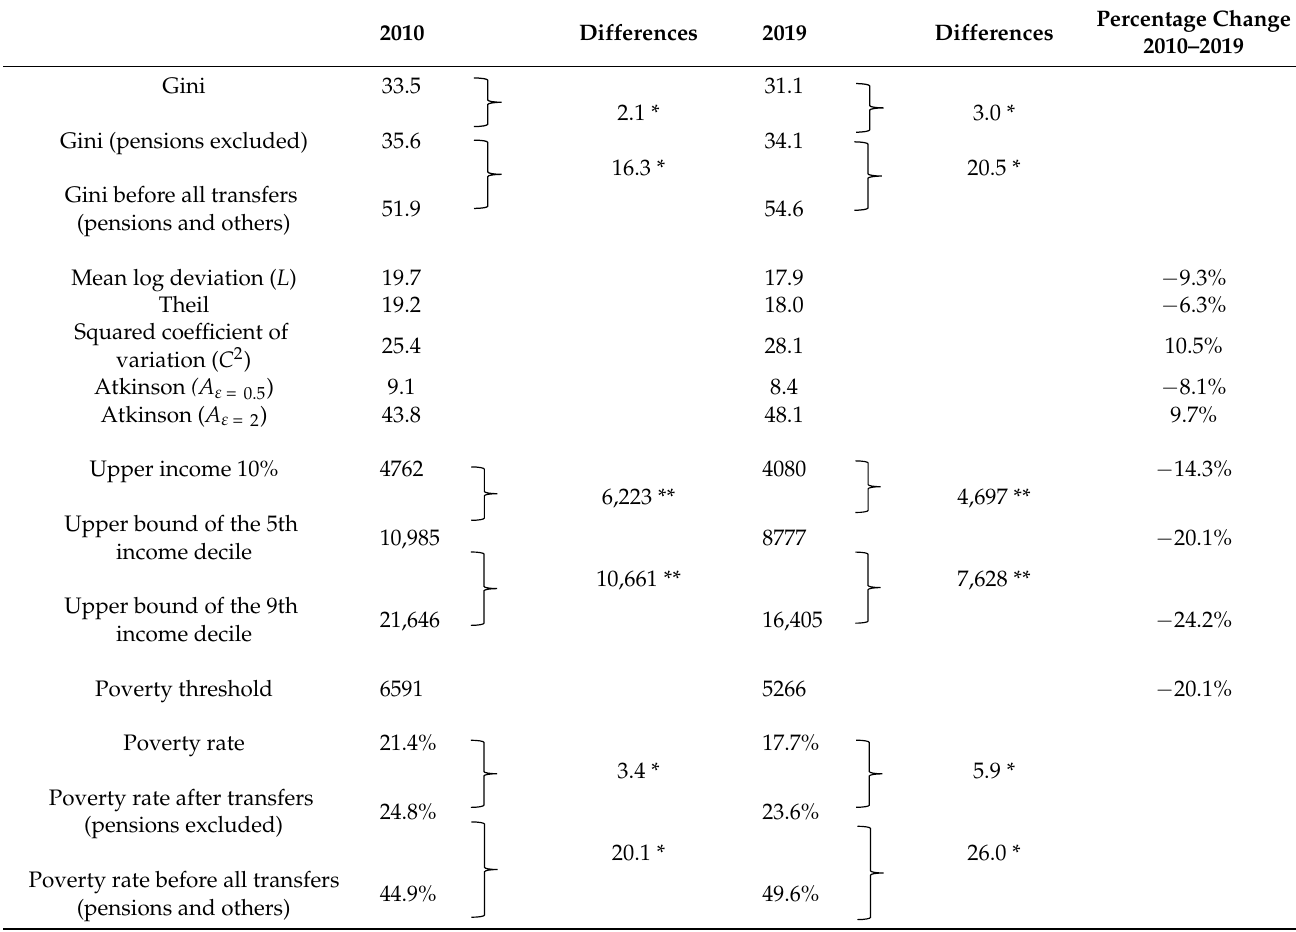
Table 1. Income inequality indices, overall population, 2010 and 2019, Greece.